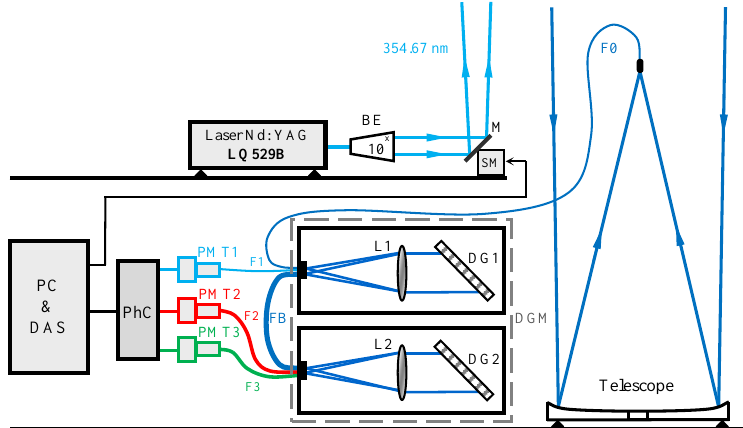
Figure 2. IMCES lidar optical layout (see also Table 1): PC & DAS indicates personal computer and data acquisition system; PhC is the photon counter; PMT1–PMT3 are photomultiplier tubes; F0–F3 are optical fibers; FB is the four fiber bundle, connecting two monochromator blocks; DGM is the double-grating monochromator; L1 and L2 are lenses; DG1 and DG2 are diffraction gratings; BE is the beam expander with expansion factor of 10; M is the mirror; SM is the stepping motor.